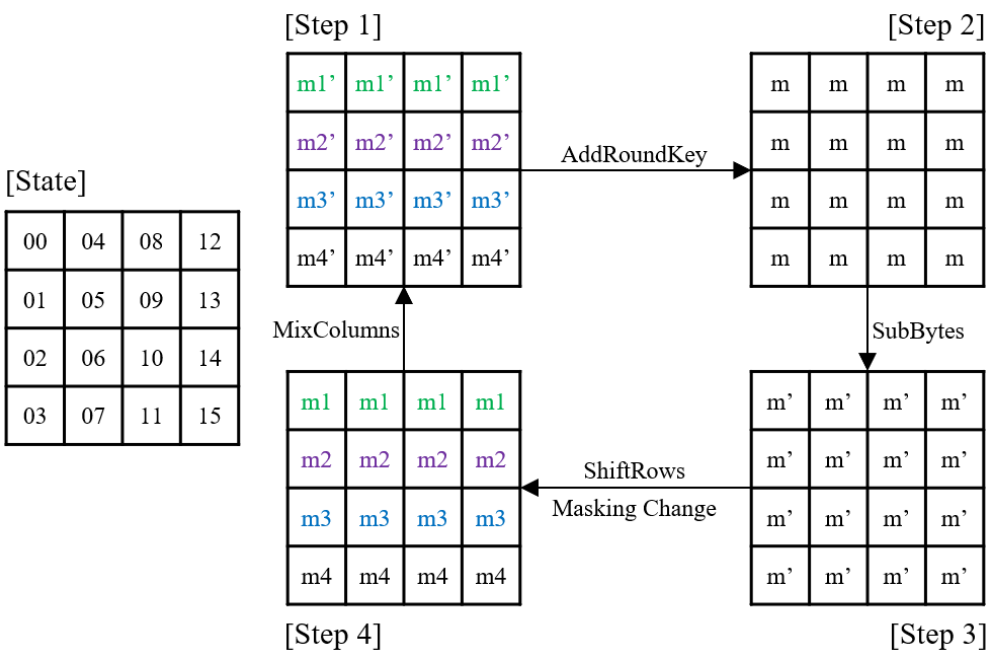
Figure 1. Masks to XOR to intermediate values for each